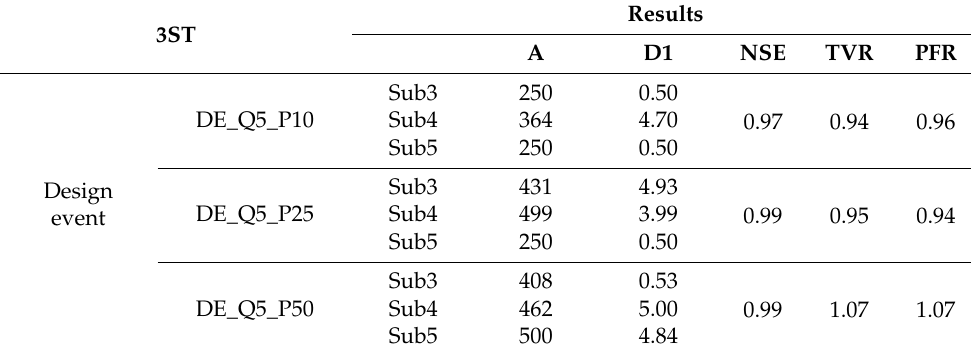
Table A2. The results of the 3ST scenario, which includes three types of a storage tank.